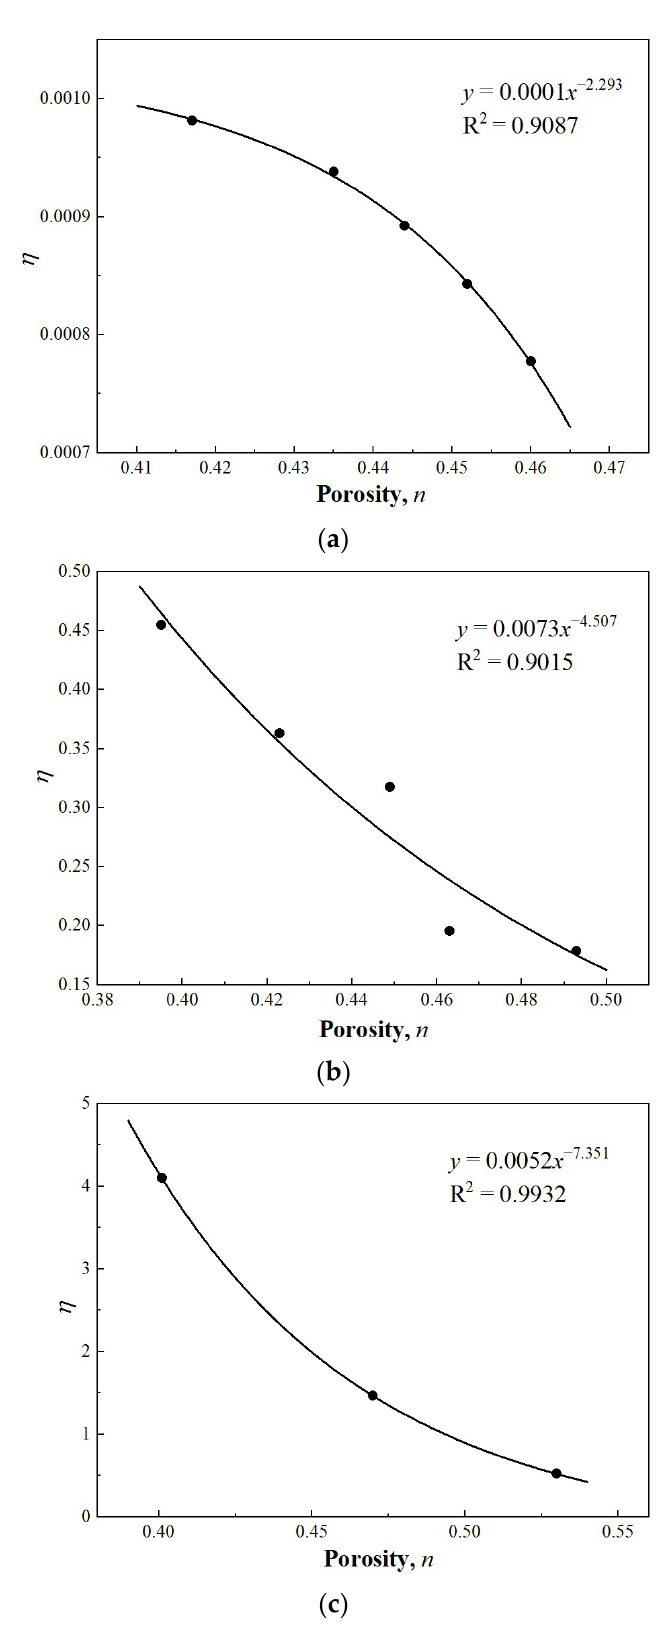
Figure 6. Relationship between porosity and soil-water force coefficient: ( a ) Unconsolidated sand; ( b ) Touchet silt loam; ( c ) microsilica.